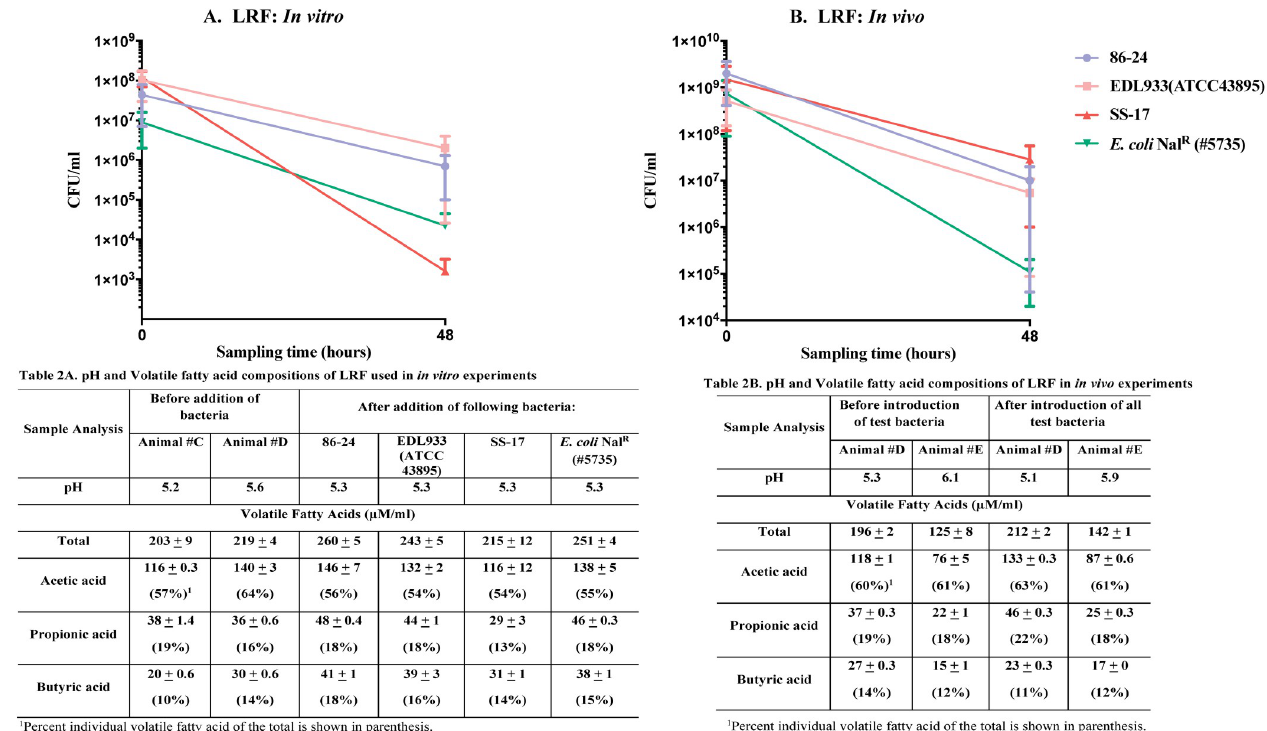
Fig 3. Graphs shown represent survival characteristics of three O157 strains in comparison to E . coli Nal R (#5735), in vitro (A) and in vivo (B), in LRF. Bacterial survival characteristics depicted are following anaerobic incubation for 48 h, in vitro in flasks with LRF or in vivo in the rumen of animals fed the lactation diet. Viable counts in colony forming units [cfu]/ml, with the standard error of means, are shown in both graphs. Inserted tables show pH and VFA composition of LRF used in the in vitro (2A) and in vivo (2B) experiments.